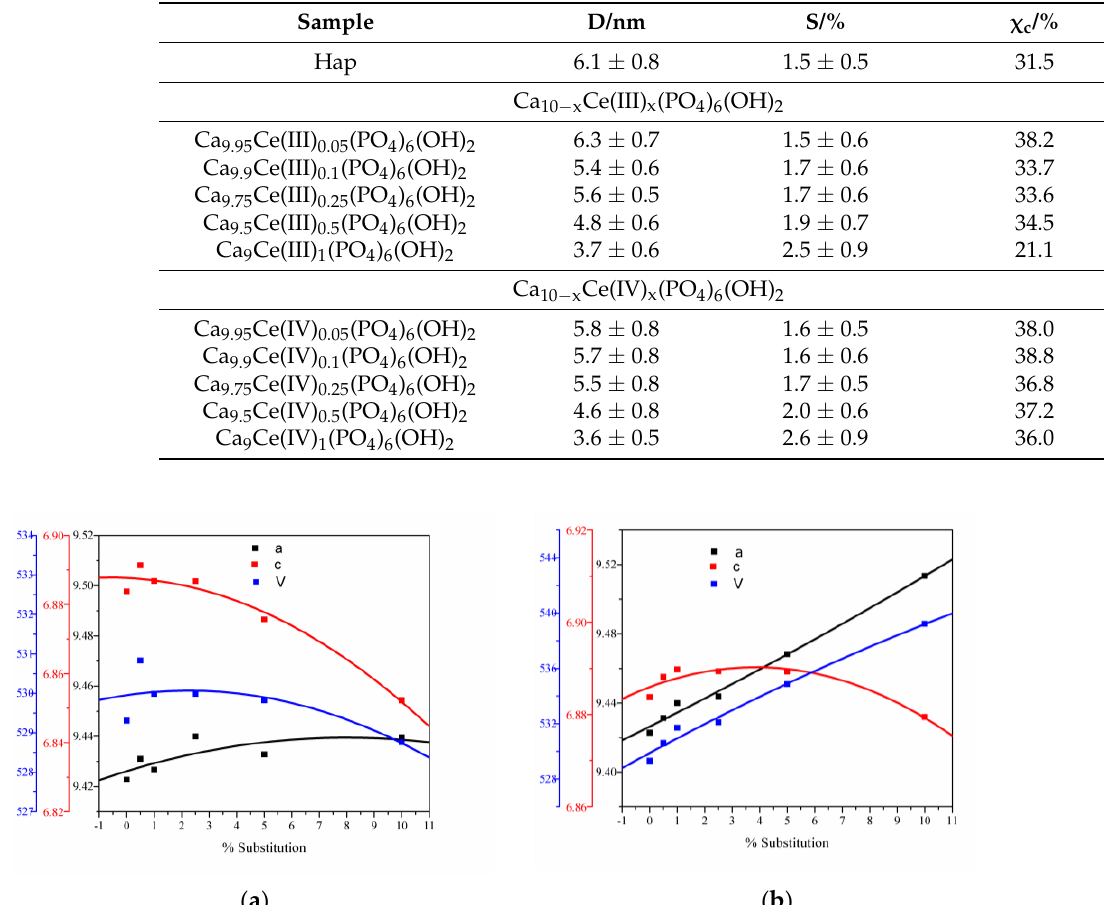
Figure 3. ( a ) Unit cell parameters versus substitution degree for Ca 10 − x Ce(III) x (PO 4 ) 6 (OH) 2 ; ( b ) unit cell parameters versus substitution degree for Ca 10 − x Ce(IV) x (PO 4 ) 6 (OH) 2 . Table 1. Calculated crystallite size (D), internal strains (S) values, and degree of crystallinity (χ c ) of pure HAp, cerium (III)-doped hydroxyapatite and cerium (IV)-doped hydroxyapatite with various concentrations.